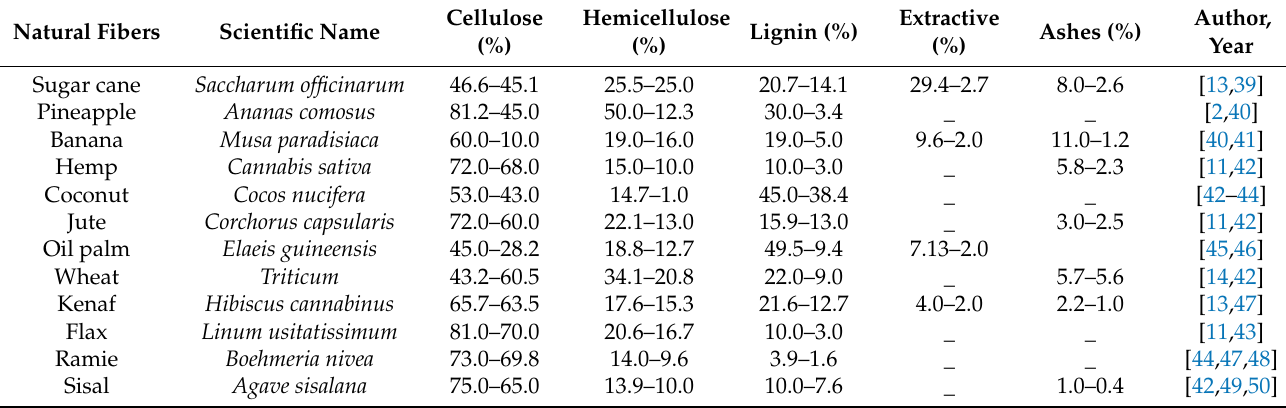
Table 2. Chemical composition of some natural